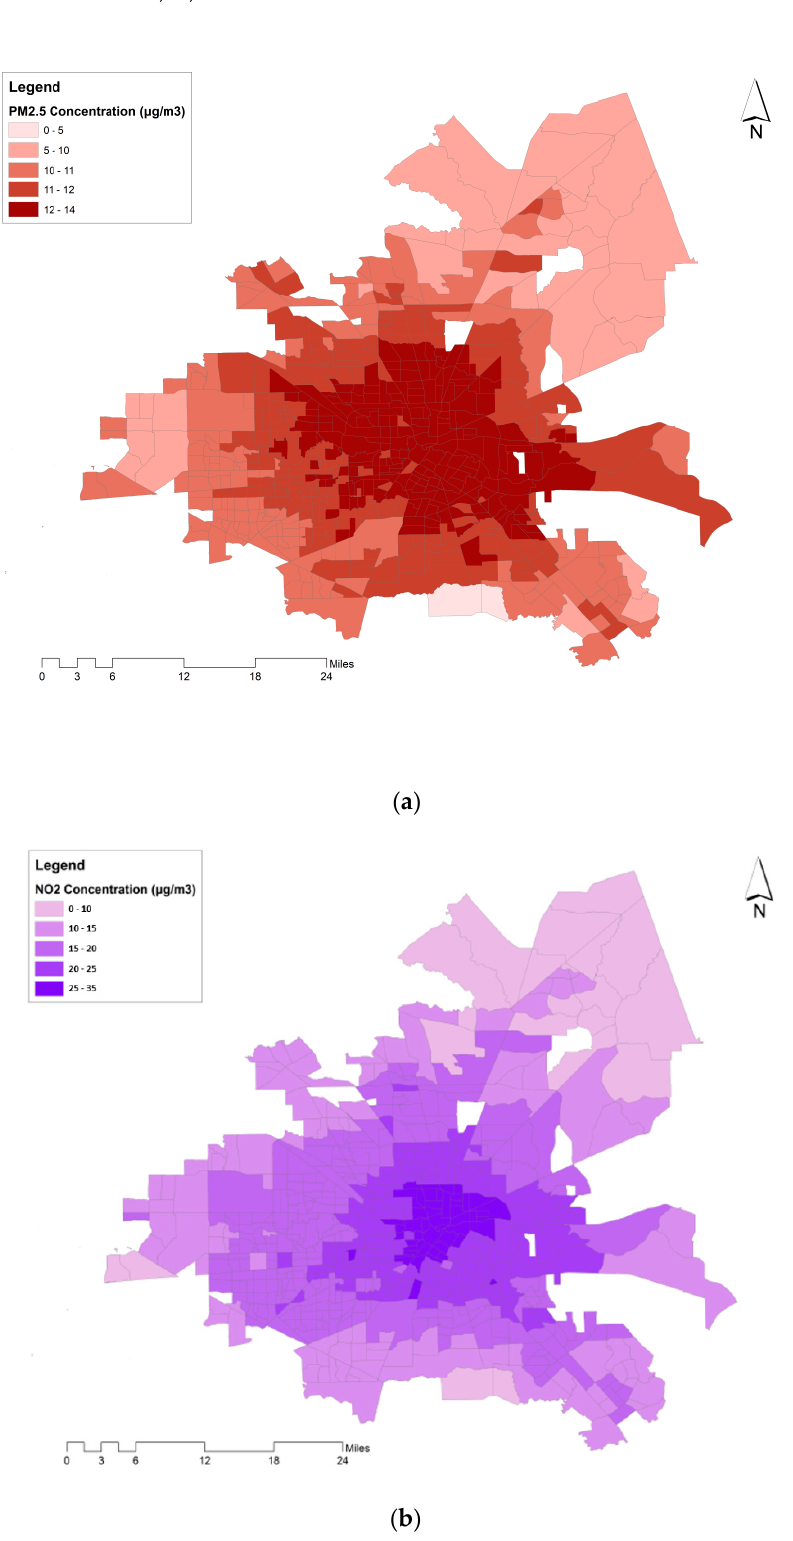
Figure 1. ( a ) PM 2.5 and ( b ) NO 2 annual average concentrations across the city of Houston at the census tract level, in